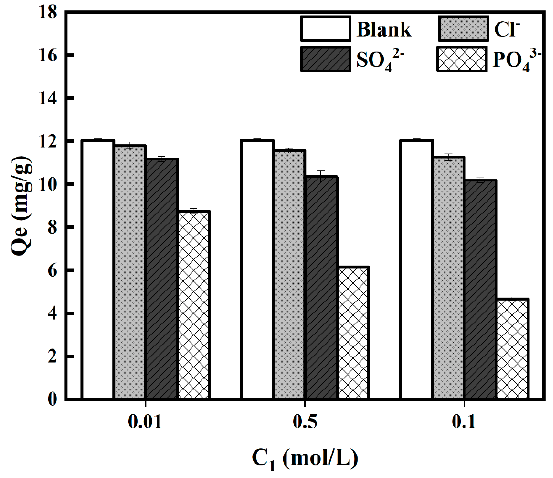
Figure 9. Effect of co-existing ions on adsorption performance ( C 0 = 150 mg/L, time = 6 h, pH = 2, temperature= 25 °C).